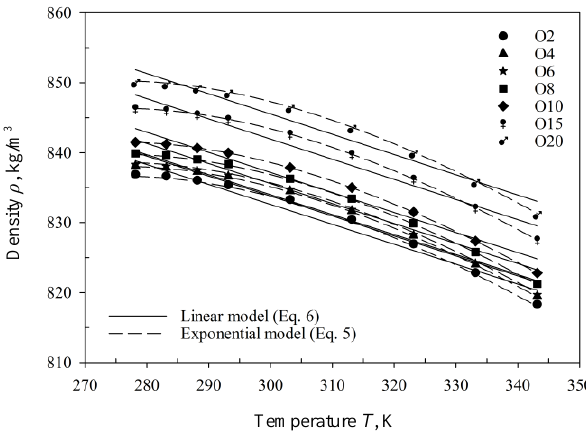
Fig. 3. Changes of densities of O2–O20 with respect to